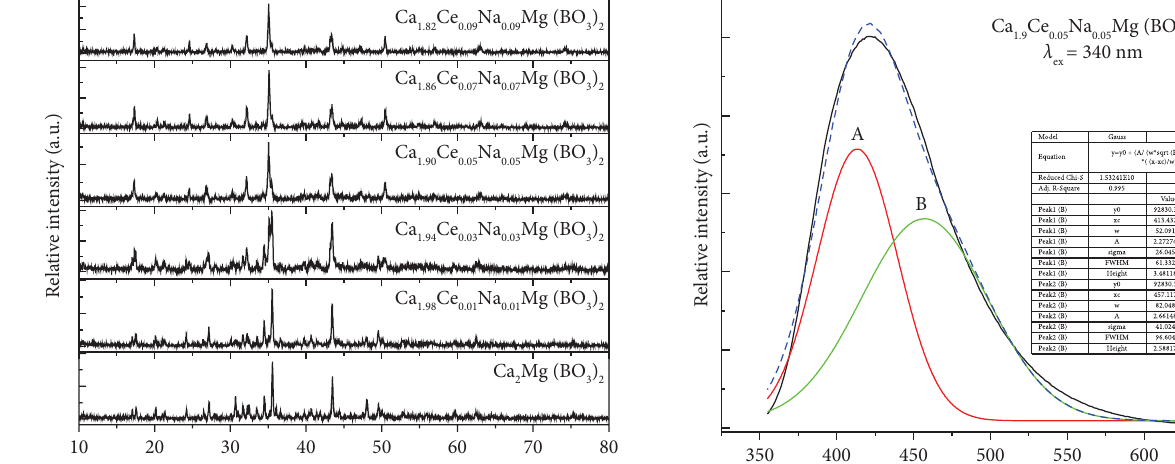
2(1 − x ) Ce x Na x Mg(BO 3 ) 2 ( x